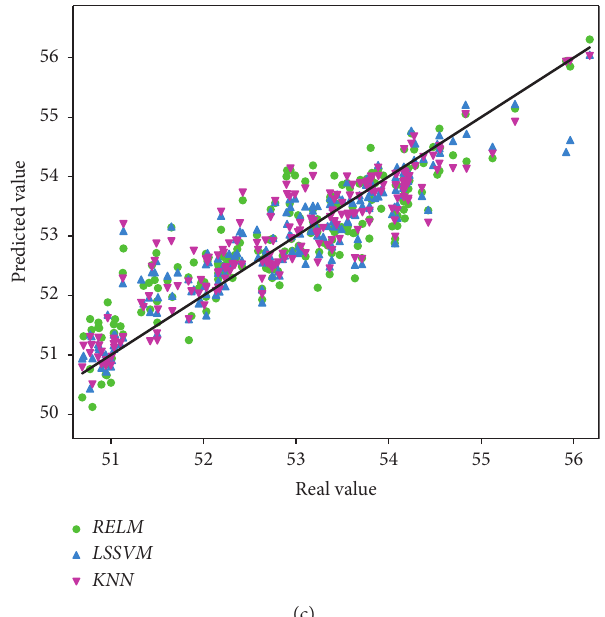
Figure 13: Experimental results under KNN and other models. (a) Prediction results under different soft-sensor models. (b) Prediction errors under different soft-sensor models. (c) Predicted scatter plots under different soft-sensor models.